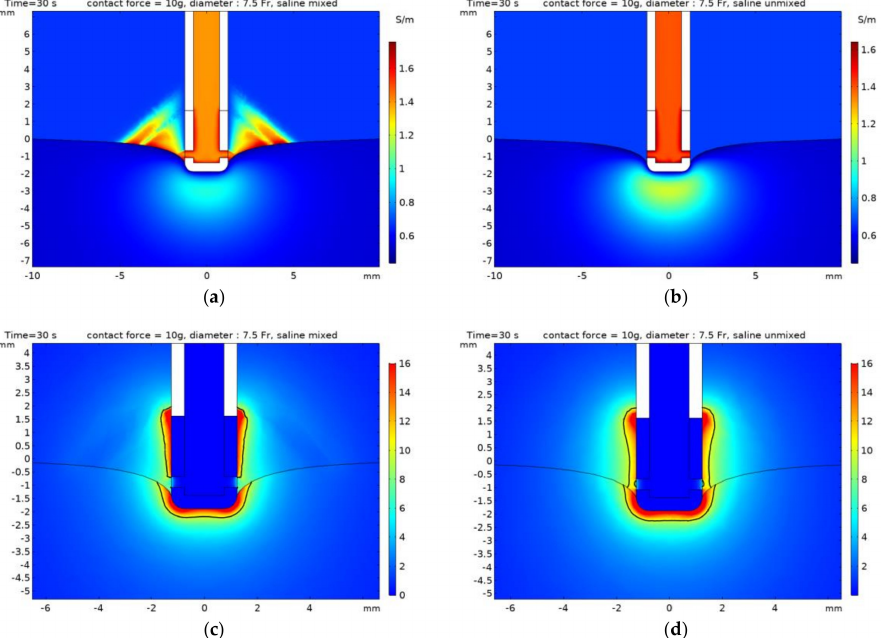
Figure 8. The distribution of electrical conductivity ( a , b ) and the electric field ( c , d ) with contour (black line) of 10 V/mm in the xz plane with catheter diameter of 7.5 Fr and contact force of 10g. ( a , c ) model mixed saline, ( b , d ) model